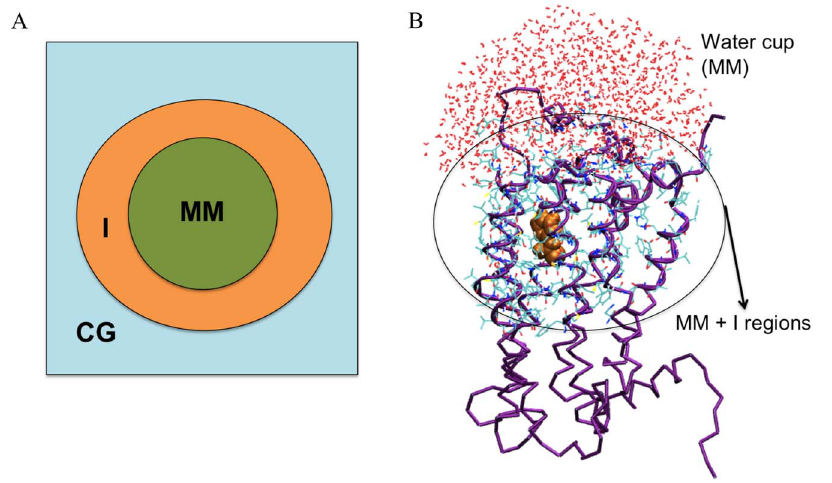
Figure 1. Molecular Mechanics/Coarse-grained system set-up. A) Schematic representation of the regions defined in the MM/CG model. The MM, I and CG regions are colored in green, orange, light blue, respectively. B) MM/CG representation of the hTAS2R38 receptor in complex with PTC. Water molecules and residues belonging to the MM and I regions are represented as lines. The agonist atoms are represented as orange spheres. The protein C a atoms are represented in violet.